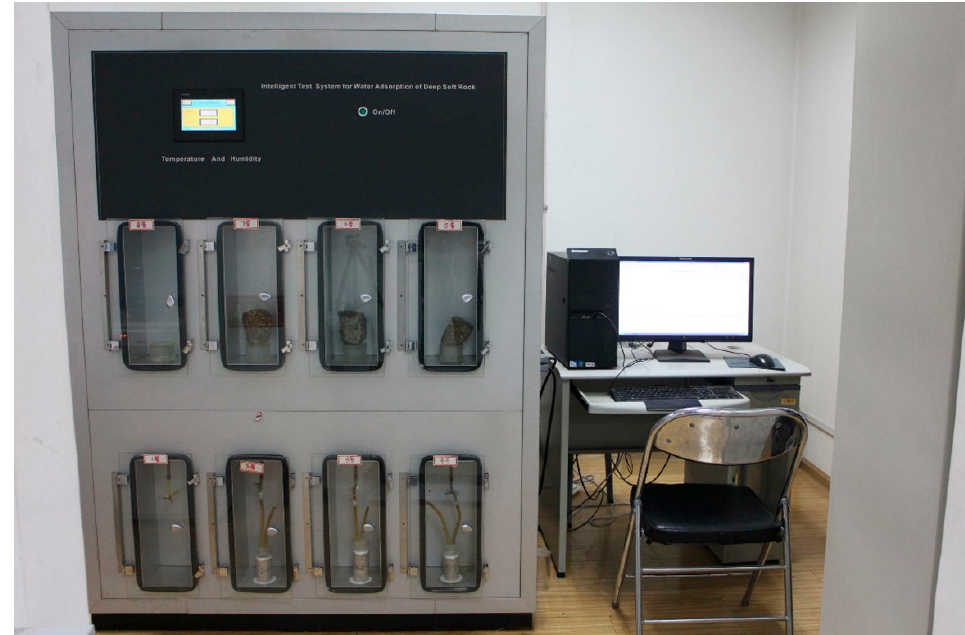
Figure 1. Physical experimental system for real-time experimental monitoring for water absorption evolution behaviors of sandstone in Mogao Grottoes, China.